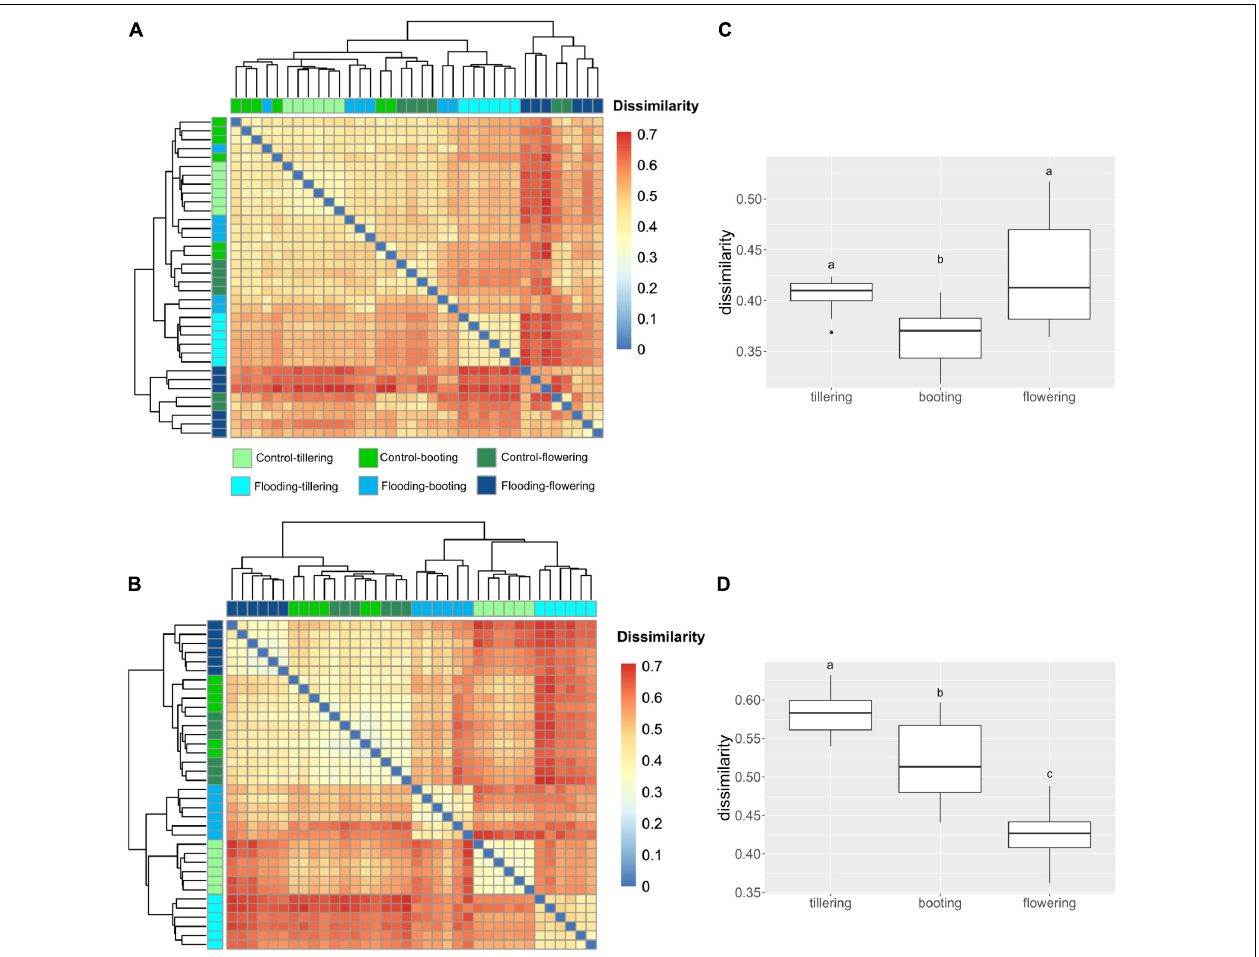
FIGURE 4 | Heatmap representing the Bray-Curtis dissimilarity in bacterial community structure between watering treatment and plant growth stages in the rhizosphere (A) and root (B) . Box plots of Bray-Curtis dissimilarity index between watering treatment and plant growth stages in the rhizosphere (C) and root (D) . The different letters indicate significant differences among plant growth stages (Tukey’s HSD test p <